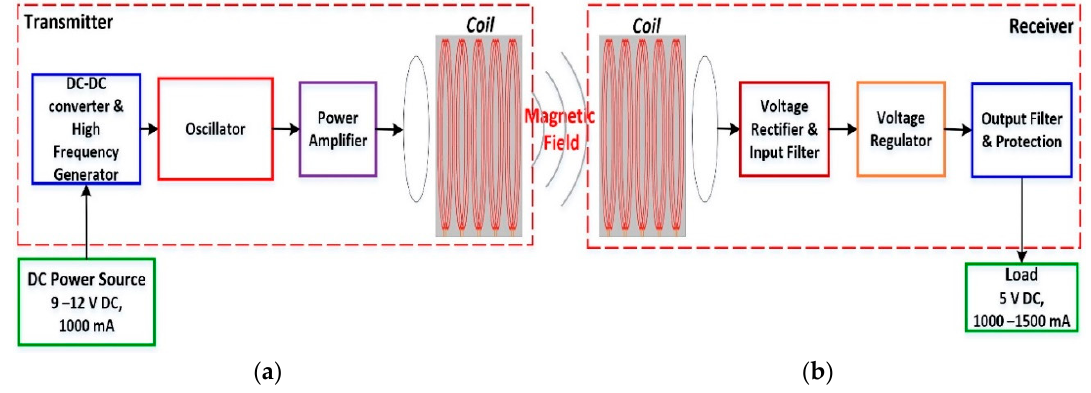
Figure 4. Block diagram Wireless power transmission (WPT) apparatus: ( a ) transmitter; ( b ) receiver.